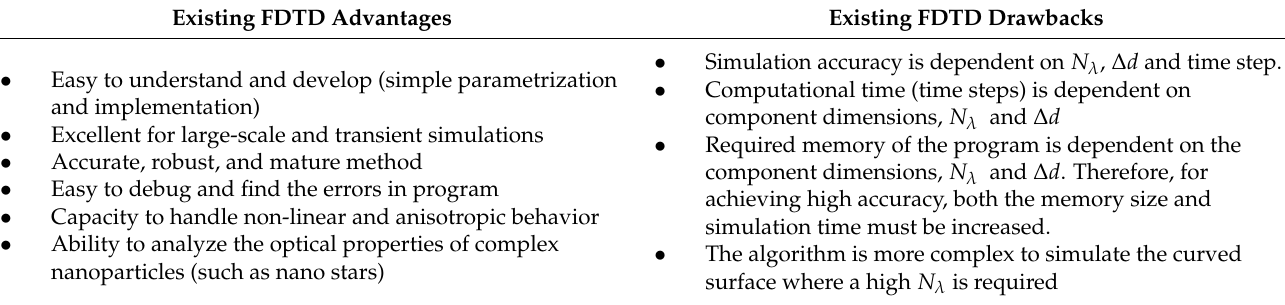
Table 1. The advantages and disadvantages of existing FDTD methods.